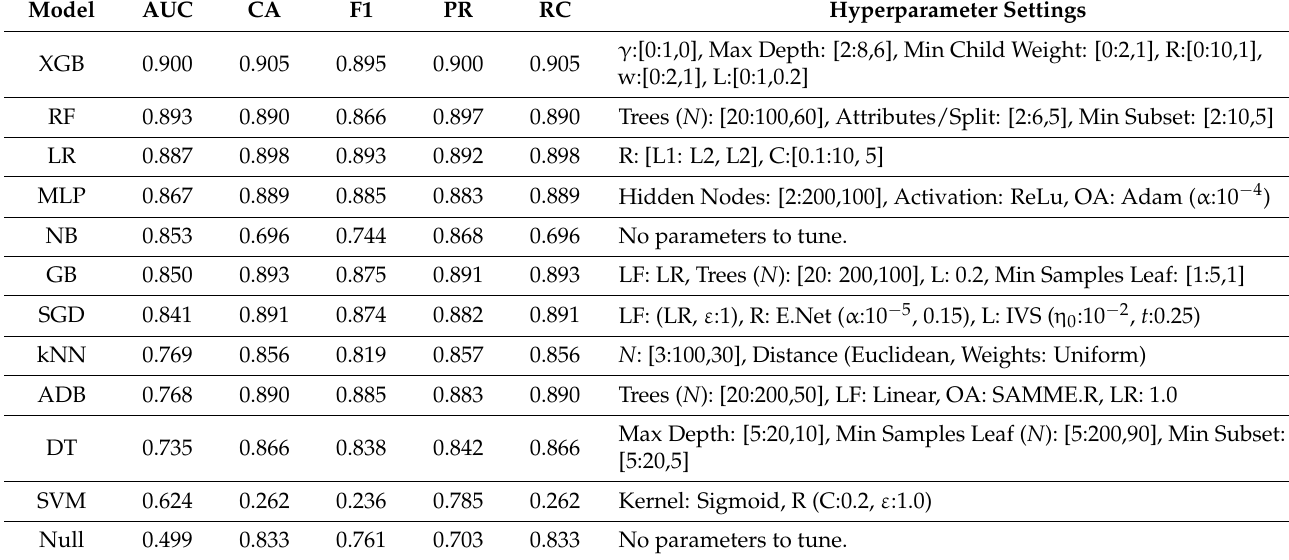
Table 4. Average scores for class predictions using OvR classification and hyperparameter settings.